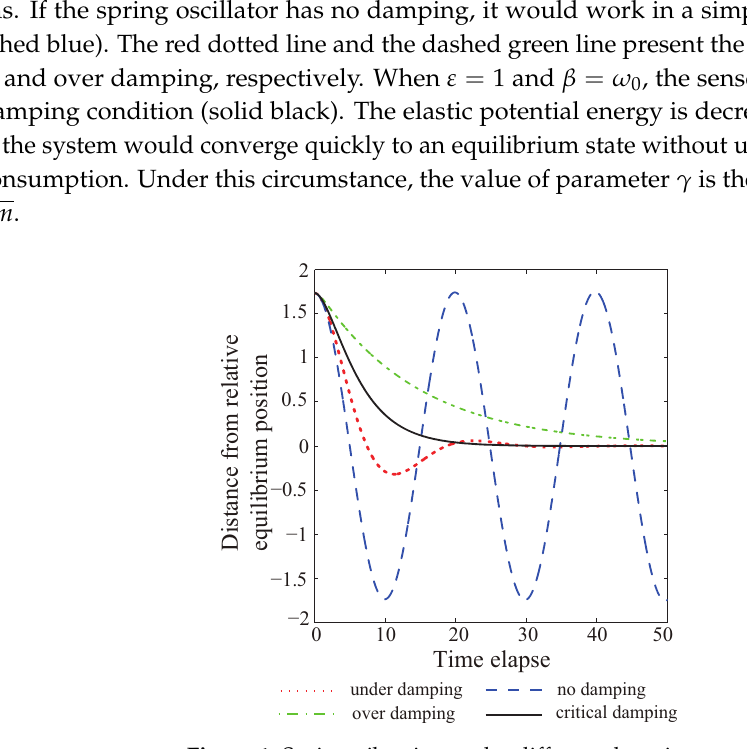
Figure 1. Spring vibration under different